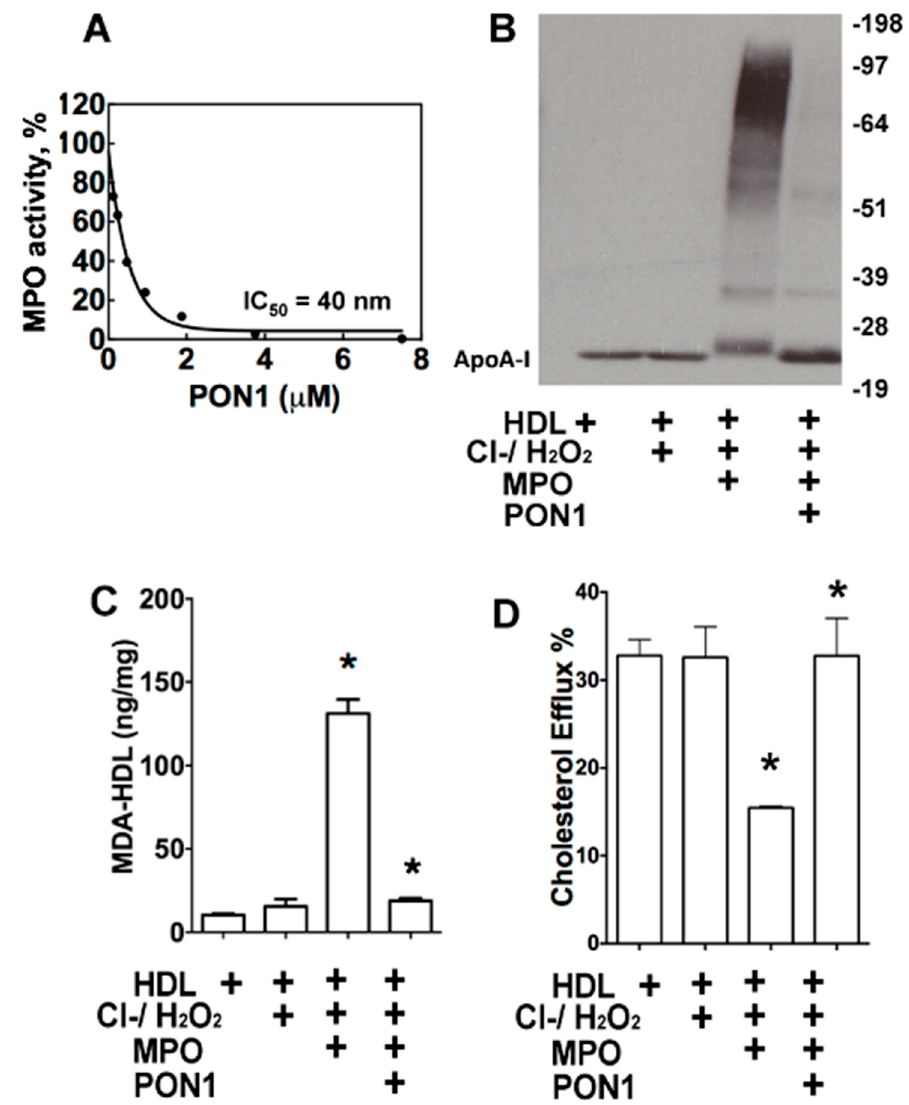
Figure 2. PON1 inhibits MPO-mediated HDL apoAI crosslinking, decreases MDA-HDL adduct levels and preserves HDL function. The MPO-mediated HDL modification reactions were performed in 50 mM phosphate bu ff er (pH 7.0) containing 100 µ M DTPA, 1 mg / mL protein of HDL, 70 nM purified human MPO and 100 mM chloride. For the PON1 inhibition reaction, 1 U / mL PON1 was incubated with 1 mg / mL HDL for 10 min and then 70 nM MPO, 80 uM H 2 O 2 , and 100 mM NaCl were added to initiate the reaction. The reactions were carried out at 37 ◦ C for 1 h. MPO peroxidase activity is inhibited by PON1 as determined by an L-012 biochemical luminescence assay ( A ) and PON1 attenuates the crosslinking of apoAI in HDL oxidized by MPO ( B ). PON1 decreases the levels of MDA-HDL adducts ( C ) and attenuates HDL cholesterol e ffl ux in MPO-mediated HDL oxidation ( D ). ( B – D ) Reactions were HDL alone, HDL with 80 µ M H 2 O 2 , HDL with 100 mM NaCl, 80 µ M H 2 O 2 , and MPO, and HDL with PON1, 100 mM NaCl, 80 µ M H 2 O 2 , and MPO. Graphs represent data (mean ± SEM) of three experiments; * p < 0.05 is indicated by comparing with HDL group or with MPO-mediated HDL oxidation group ( D ) using one way ANOVA.